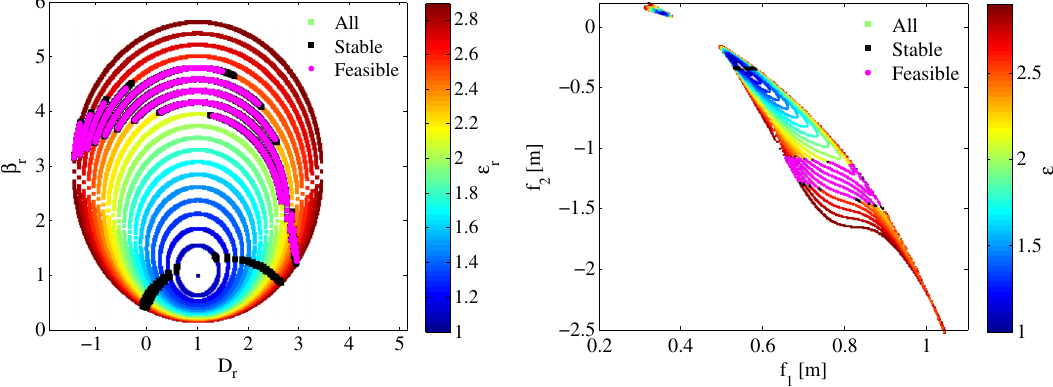
FIG. 5. Parametrization of the relative horizontal beta β focal lengths (right), with the cell detuning factor ϵ feasible ones with the magenta